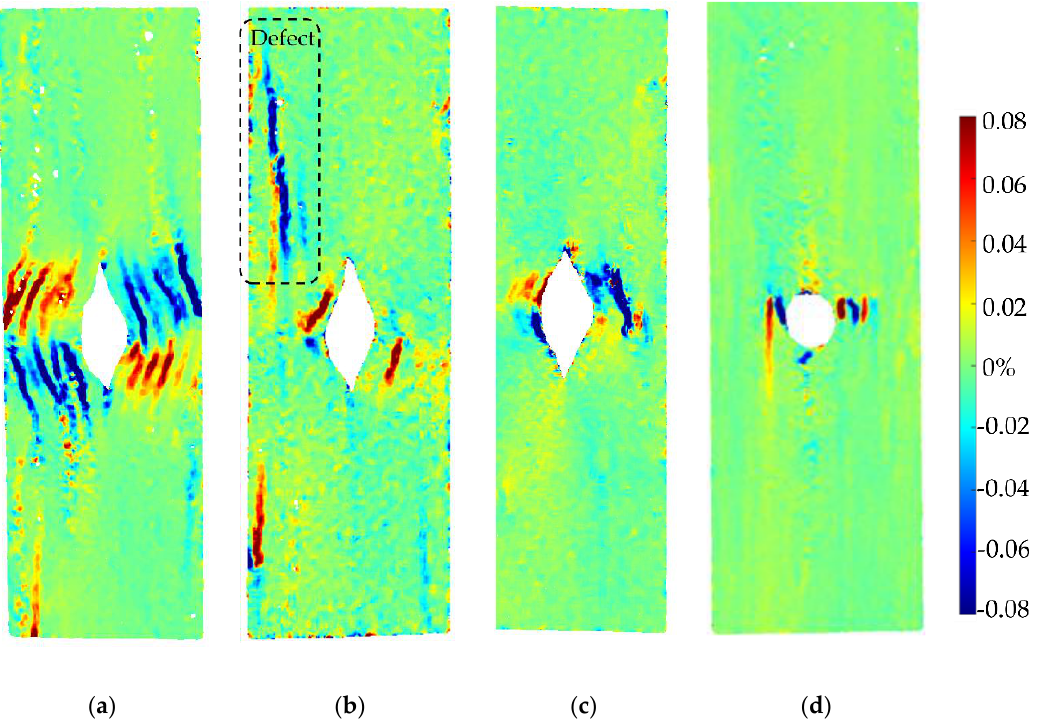
Figure 14. DIC analysis of in-plain shear strain ( ε xy ) at the maximum load of each sample in different types: ( a ) printed 10C at 59.77 MPa; ( b ) 4C at 100.5 MPa; ( c ) 4C-Oven at 159.2 MPa (post-printing consolidated part); ( d ) tapes at 166.4 MPa (layup part with a punched